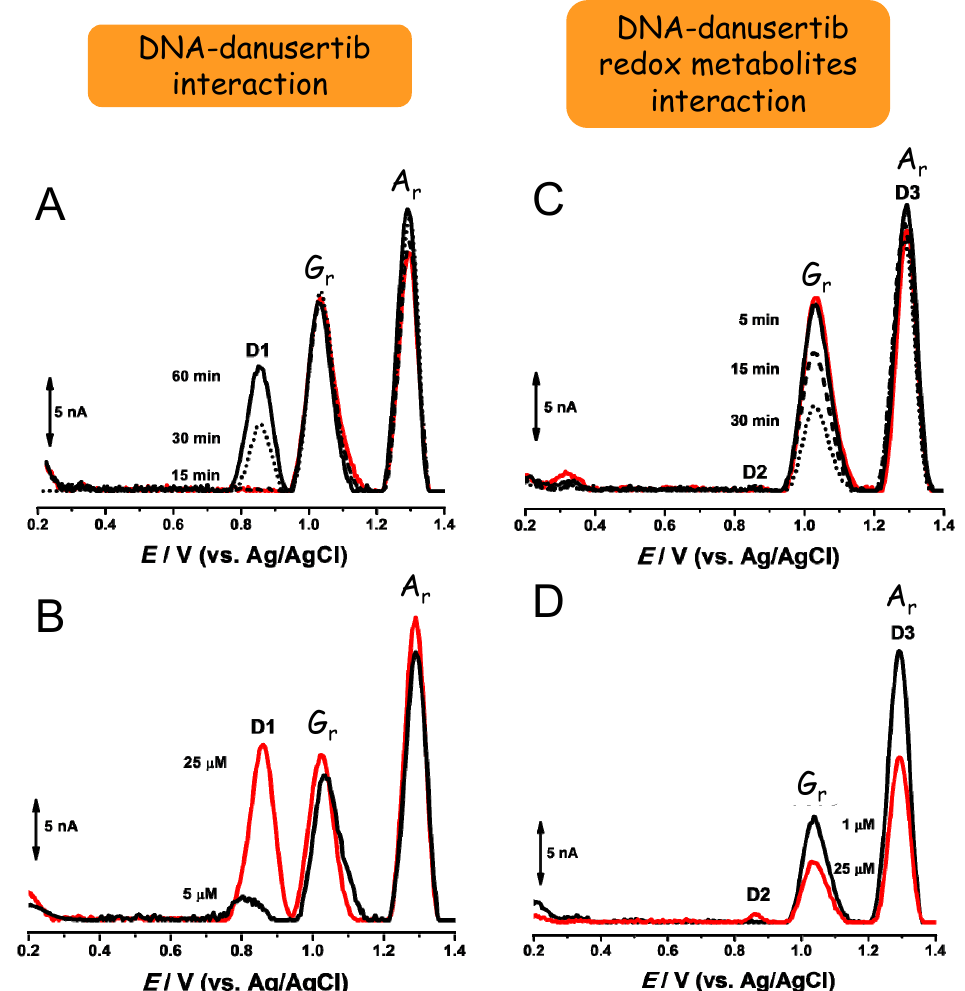
Figure 7. Baseline-corrected DPV at pH = 4.5, with a dsDNA electrochemical biosensor, ( A , B ) without conditioning potential and ( C , D ) with conditioning potential of +0.85 V (vs. Ag/AgCl, 3 M KCl): ( A , C ) (red line) 30 min in buffer, and (black lines) incubation in 10 µM danusertib for different time periods, and ( B , D ) incubation in (black line) 5 µM and (red line) 25 µM danusertib for 30 min. Adapted from [95] with permission.